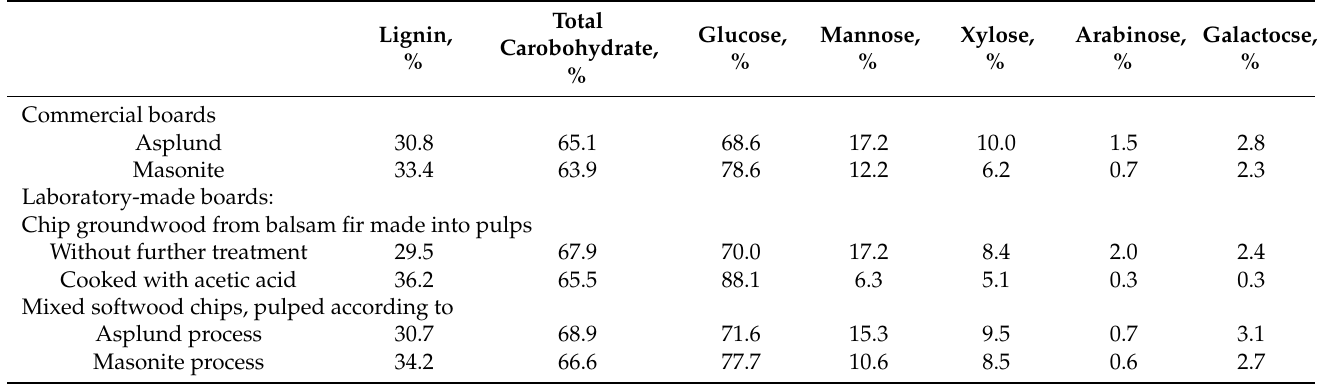
Table 9. Chemical composition of Asplund, Masonite, and laboratory-made hardboards [17].